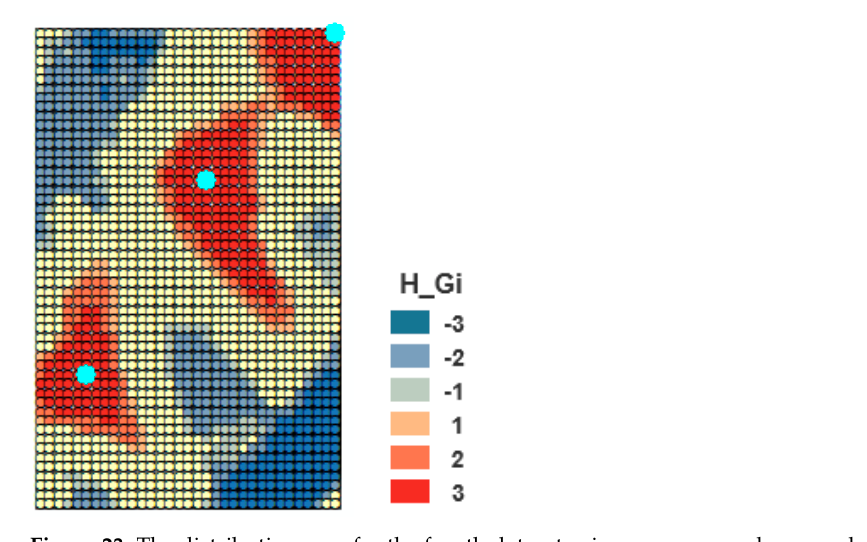
Figure 22. Distribution maps extracted by the traditional Mountain Vertices Extraction Methods using the fourth dataset. ( a ) Contour Line Method. ( b ) Neighborhood Analysis Method. ( c ) Contour line and Neighborhood Analysis Overlay Method.